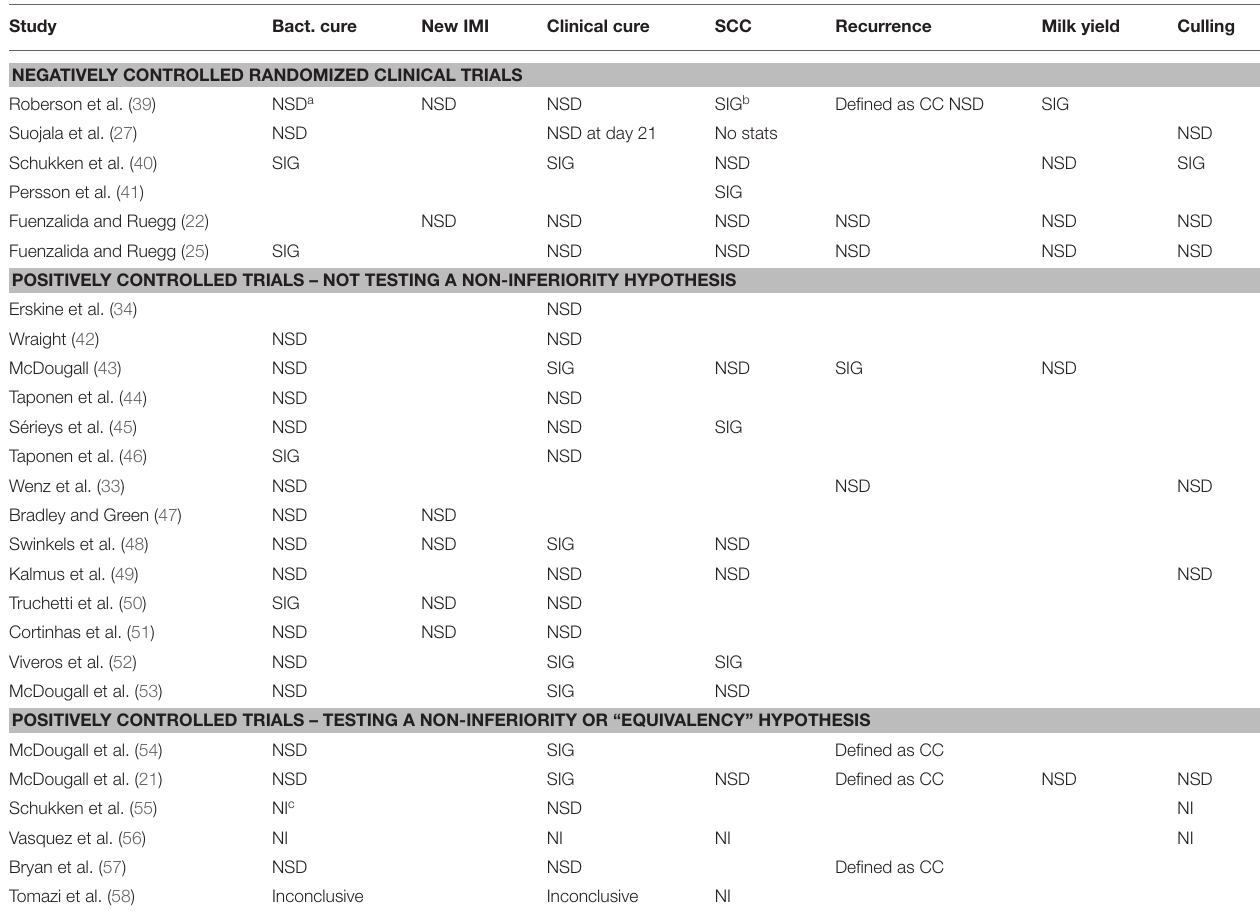
TABLE 2 | Outcomes evaluated in 26 clinical mastitis treatment